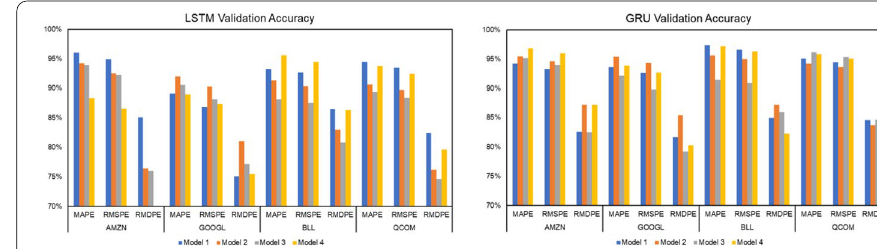
Fig. 12 Visualization graph of LSTM and GRU Trained